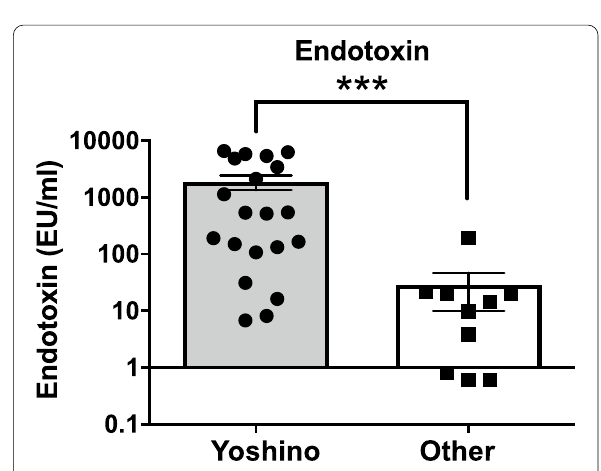
Fig. 3 Concentration of endotoxin (LPS) in Cryptomeria japonica . Concentrations of endotoxin (LPS) from aqueous extracts of Cryptomeria japonica from Yoshino ( n were measured by ELISA. Data are the mean mean. *** P < 0.001 (Mann–Whitney U